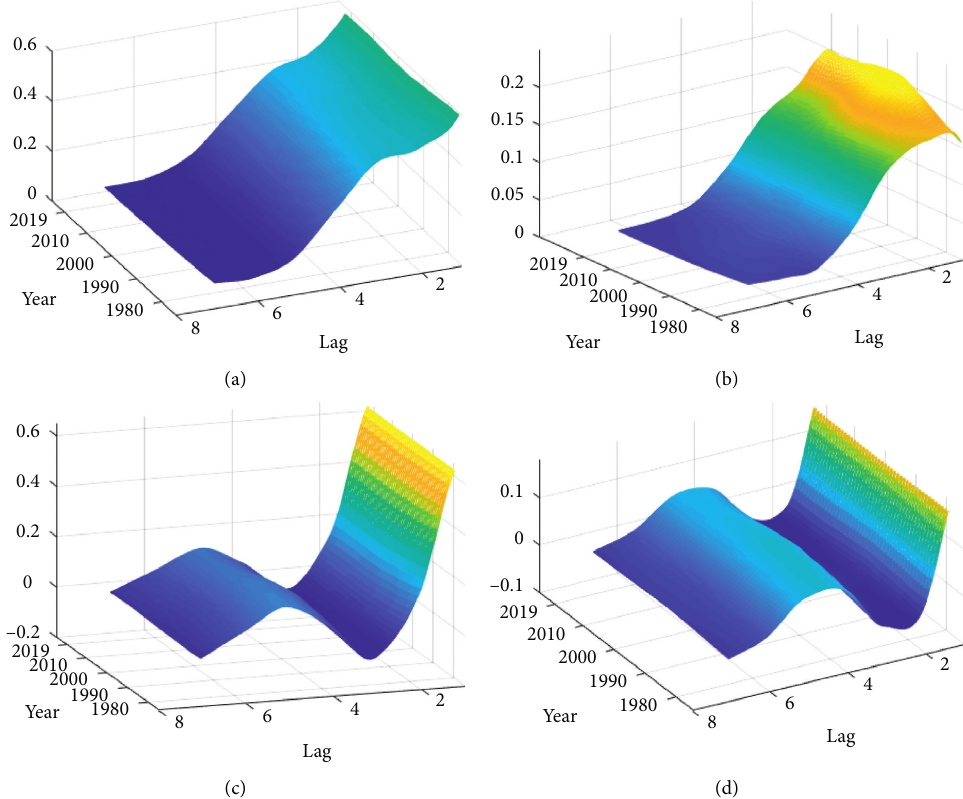
Figure 7: Analysis of stereo impulse response: (a) Δ CO 2 ↑⟶ CO 2 ; (b) Δ PCG ↑⟶ CO 2 ; (c) Δ EI ↑⟶ CO 2 ; (d) Δ IAV ↑ ⟶ CO 2